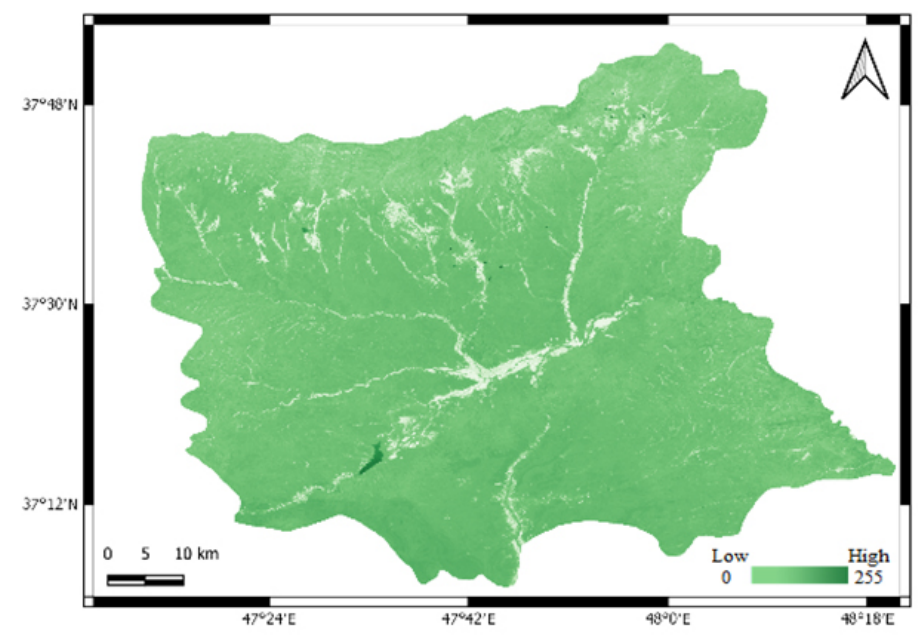
Figure 5. Soil salinity map.